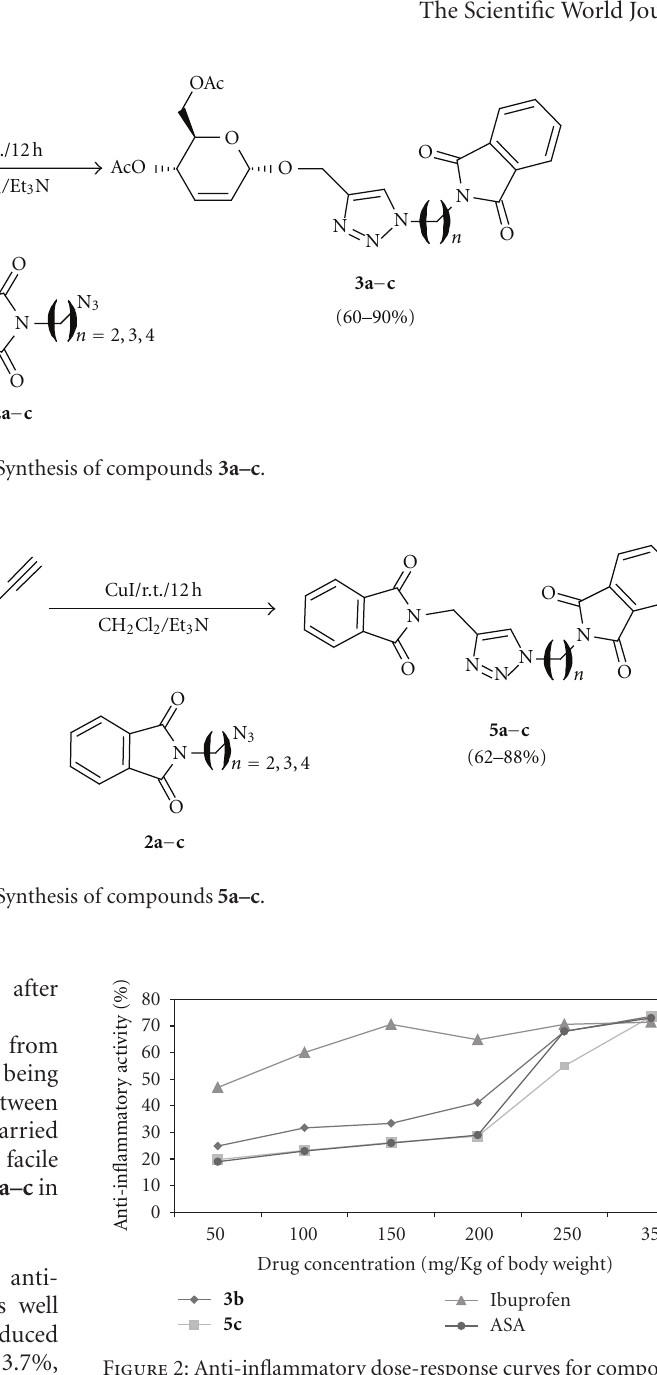
Figure 2: Anti-inflammatory dose-response curves for compounds 3b , 5c , ASA, and ibuprofen using carrageenan to produce inflam- mation in the paw of